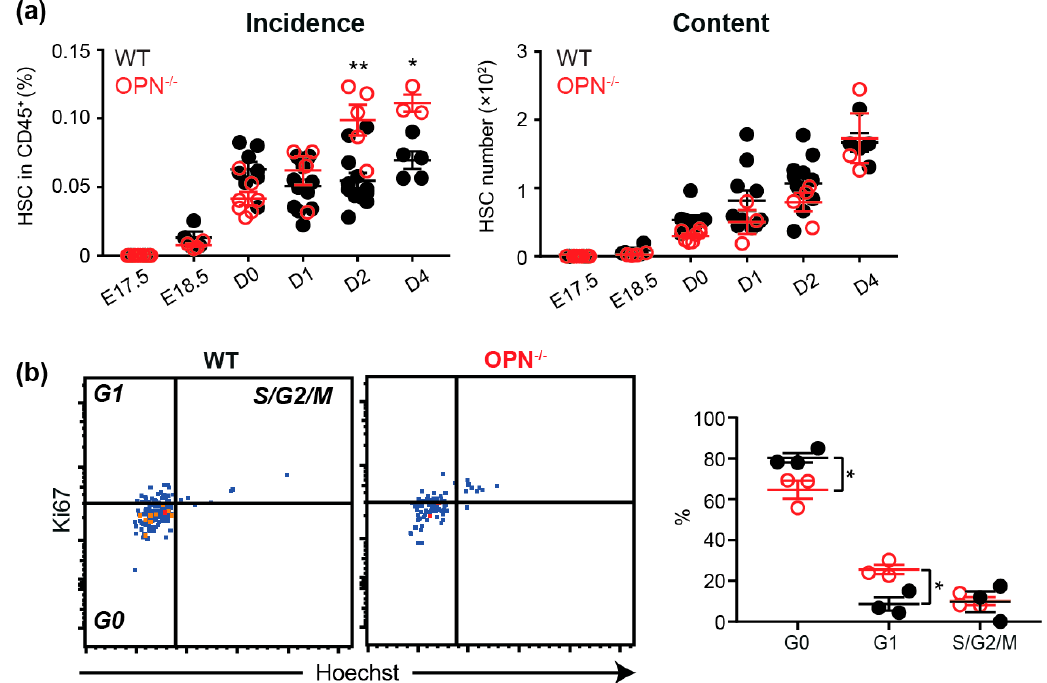
Figure 3. OPN is important in the maintenance of fetal HSC pools. ( a ) A summary of incidence and content of SLAM HSC in the fetal and neonatal BM. Data represents the cell content after normalization by mouse weights. ( b ) Cell cycle analysis with Ki67 and Hoechst on D2 BM LSKSLAM cells. Each dot represents the average value for a litter (for fetal) or an individual mouse from different litters (for newborn). WT: closed black circle; OPN -/- : open red circle; * p < 0.05, ** p < 0.01. Data shows mean ± SEM, n ≥ 3.